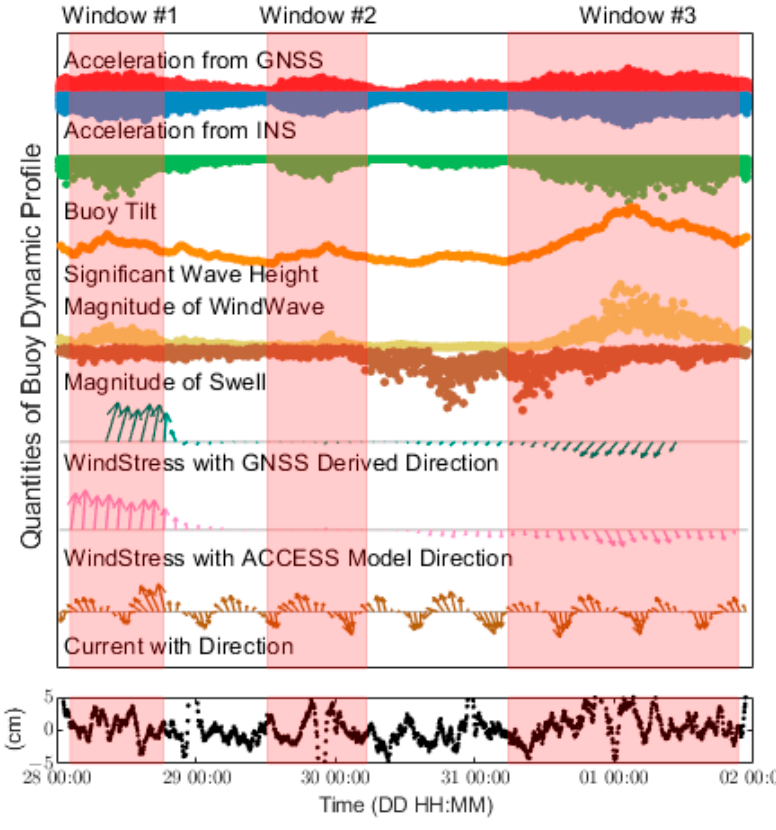
Figure 6. Dynamic profiles of the buoy based on observations and model for deployment 66. In the upper panel, quantities are provided without detailed magnitude on the y-axis for all indicators as the time correlation is the focus of the figure rather than their absolute values. Acceleration from GNSS is derived from 2-Hz SSH series, while acceleration from INS is derived based on 100-Hz IMU readings with a 2-Hz moving mean filter. Buoy tilt is calculated based on the IMU derived roll and pitch of the platform. Magnitudes of waves are normalized within [0, 1] based on their range separately. Wind stress are plotted with directional information derived from GNSS and from the ACCESS G model, while currents are plotted with directional information based on observations. The lower panel shows the B–M residual over the same time span of the deployment. Increased sea states (evident in acceleration, buoy tilt and wave magnitude) are featured in three selected time windows (shaded areas in the figure) during the deployment.